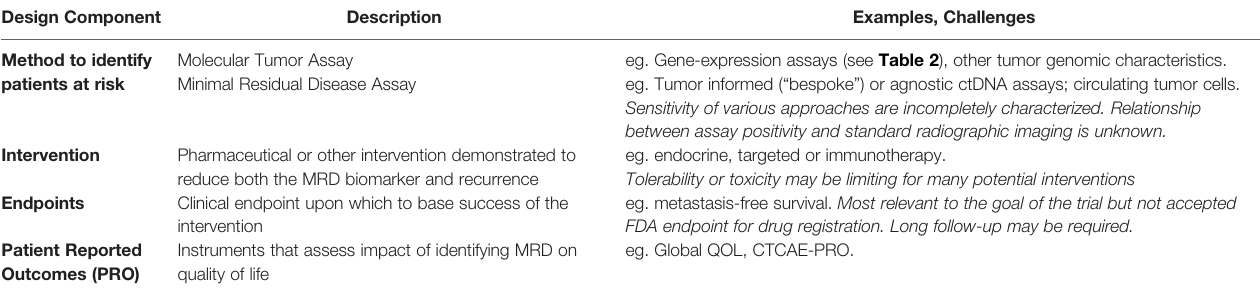
TABLE 1 | Design components needed for a late recurrence